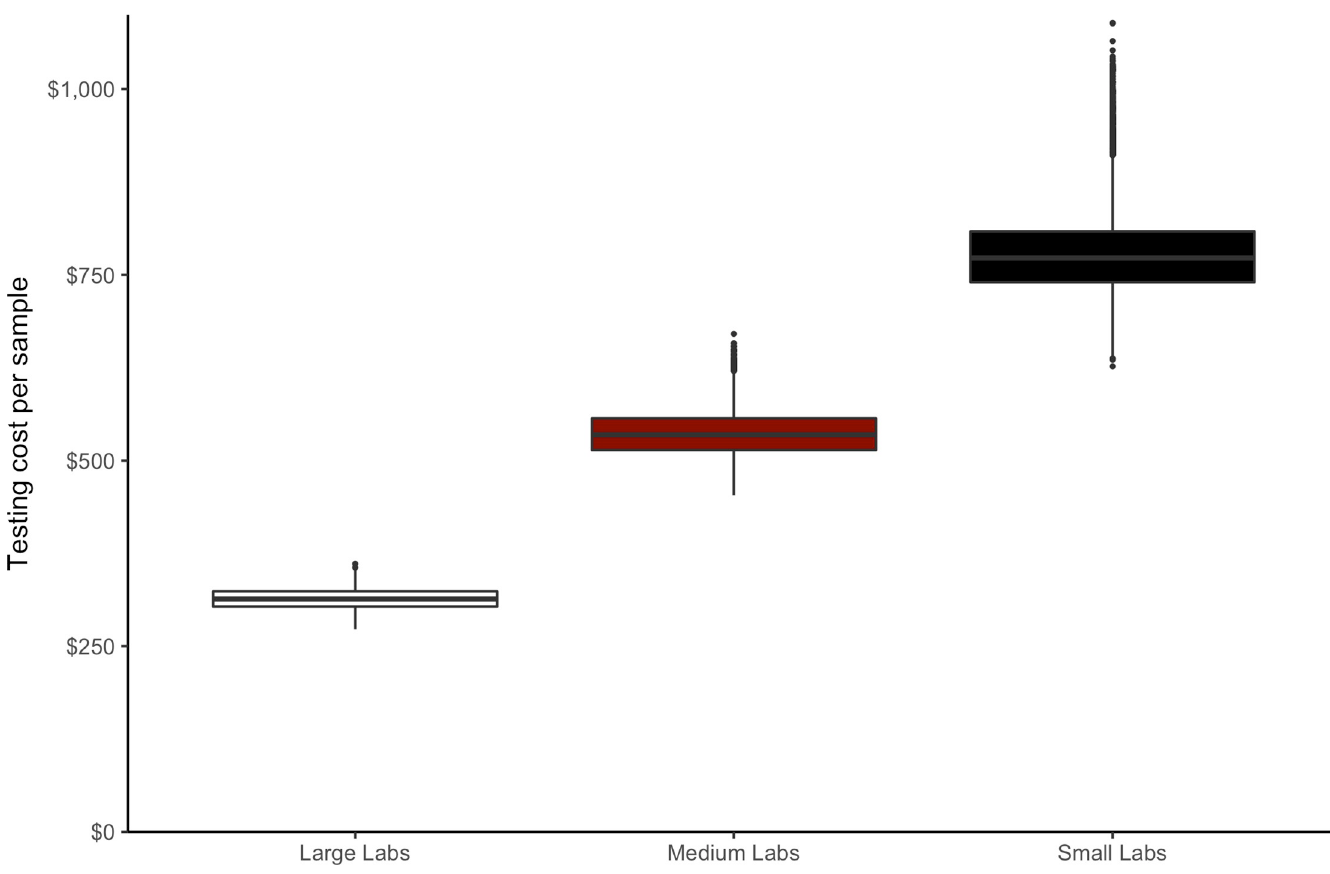
Fig 4. Testing cost per sample from a batch of cannabis flower ( C i ) estimated for small, medium, and large labs using 1,000 Monte Carlo simulations.